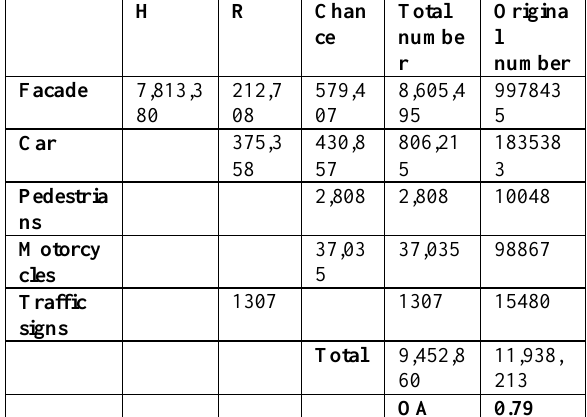
Table 2. The confusion matrix of the Paris-rue-Madame dataset using box classification (OA: overall